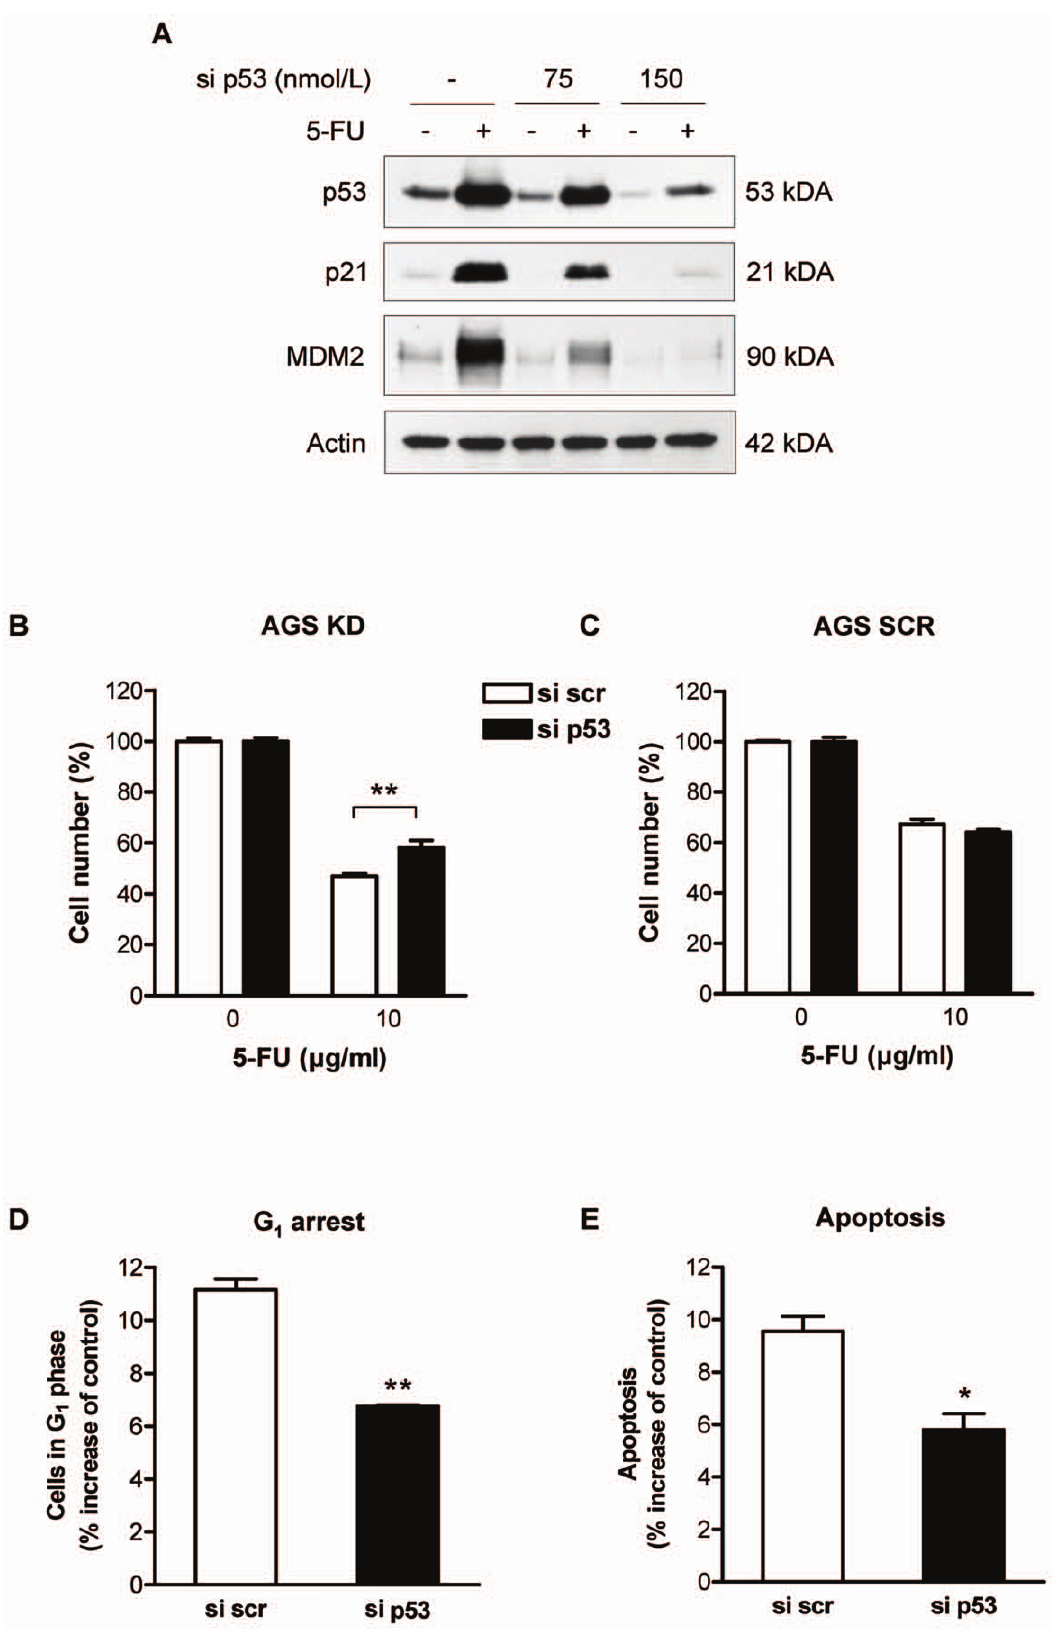
Figure 3. siRNA silencing of p53 reverses the chemosensitization of AGS KD cells. AGS cells were transfected with control siRNA (si scr) or siRNA against p53 (si p53), and 10 m g/ml 5-FU was added 24 h post transfection. (A) Immunoblot analysis for p53, p21 and MDM2 in whole cell PLoS ONE |